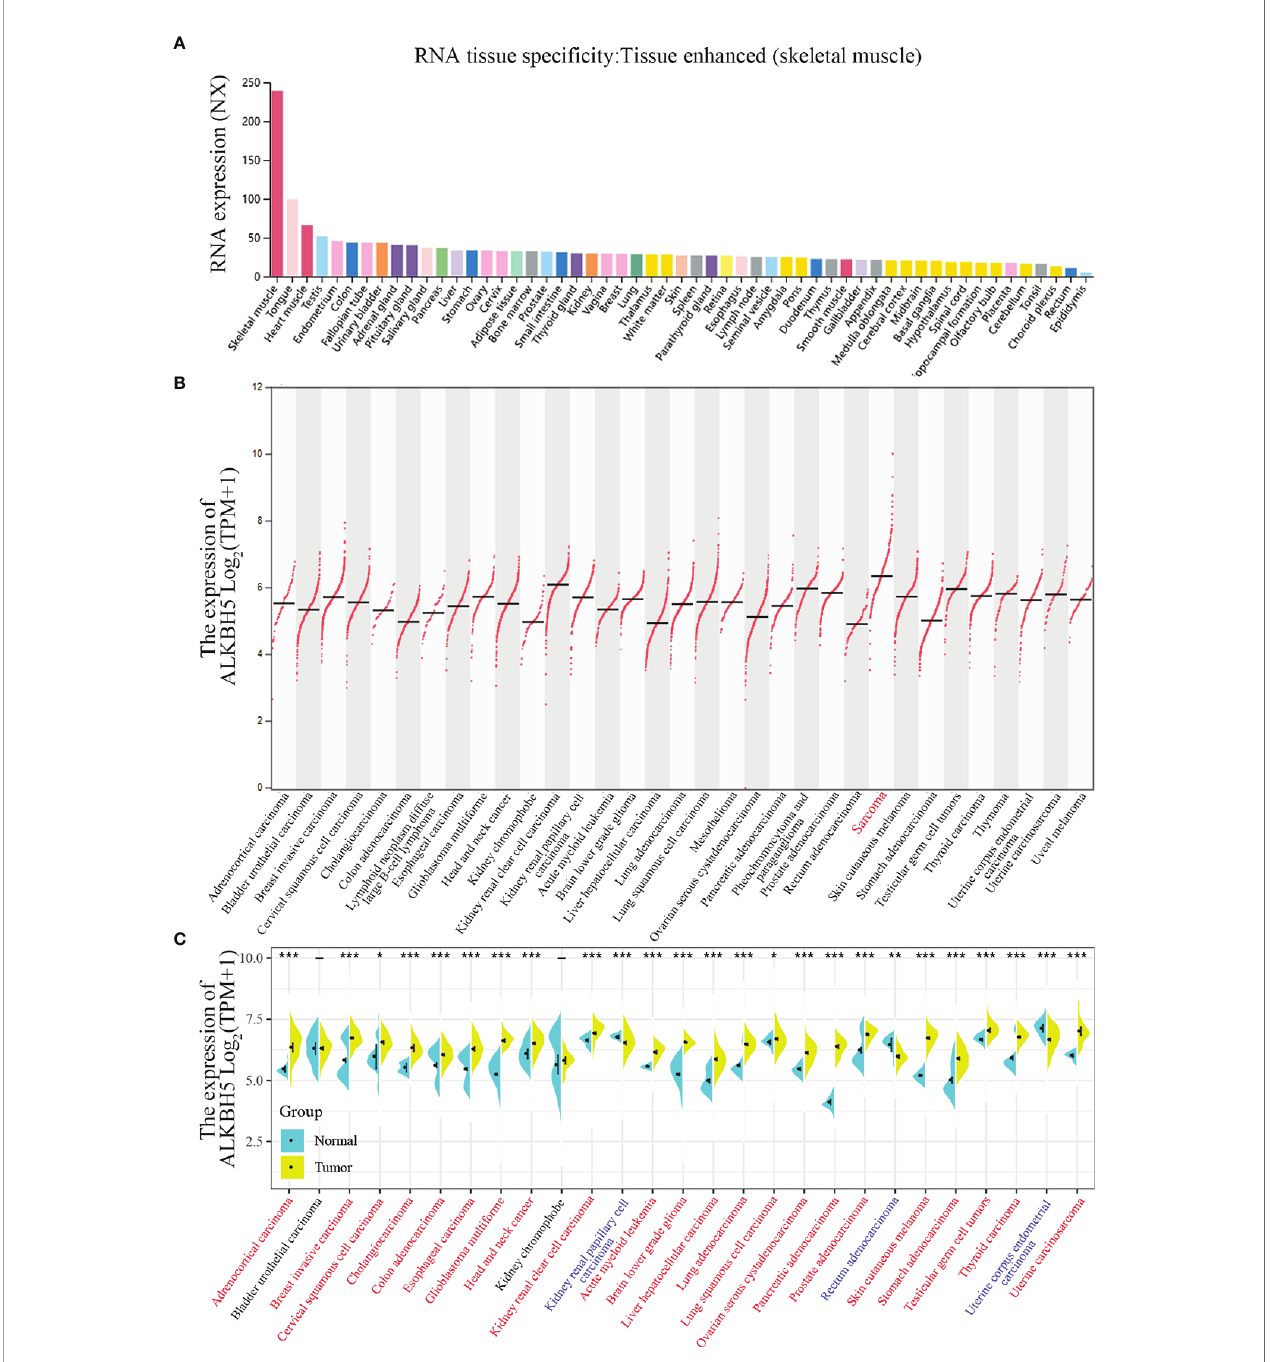
FIGURE 1 | ALKBH5 expression levels in normal tissues and cancers. (A) ALKBH5 consensus Normalized eXpression (NX) levels for 54 normal tissue types and 7 blood cell types, generated by the three transcriptomics datasets (GTEx, HPA and FANTOM5); (B) ALKBH5 mRNA expression levels in 33 different tumor types from TCGA database via GEPIA2 portal (Sarcoma with the highest expression is shown in red label); (C) ALKBH5 mRNA expression levels in different tumors and corresponding normal tissues from TCGA and GTEx database by SangerBox. Red label tumors represented up-regulation of ALKBH5 compared with corresponding normal tissues, blue label tumors represented down-regulation of ALKBH5 compared with corresponding normal tissues, and black label tumors represented no signi fi cant difference of ALKBH5 between tumor tissues and corresponding normal tissues or absence of normal samples. * P <0.05, ** P <0.01, *** P